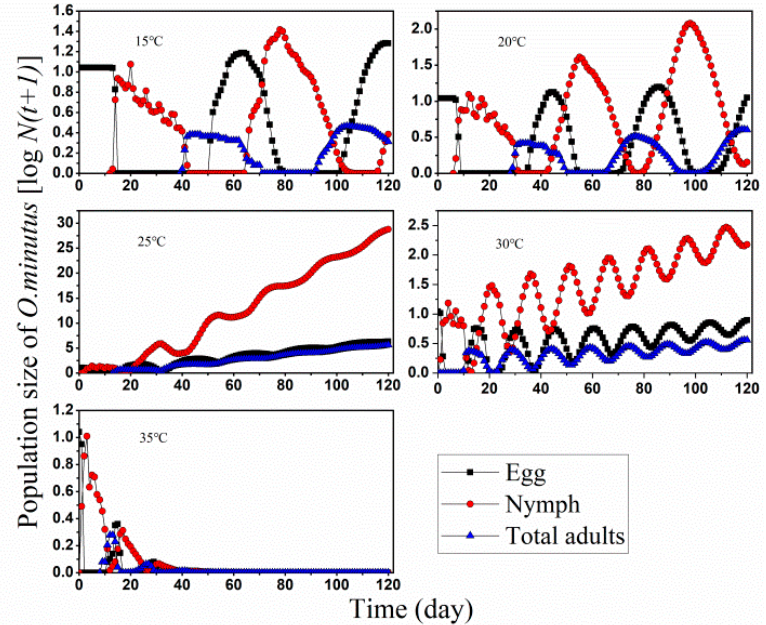
Figure 5. Simulation of O. minutus population fed on D. minowai starting from 10 eggs at five temperatures from 15 to 35 °C through a period of 120 d.